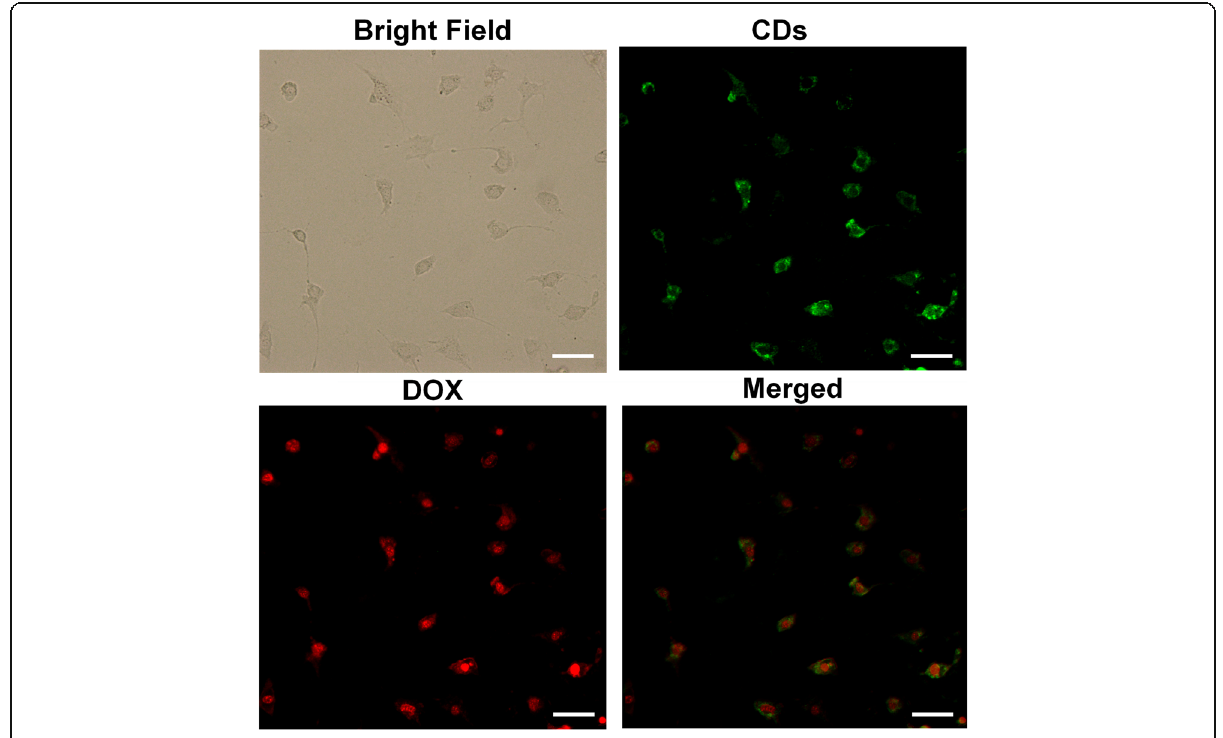
Fig. 4 In vitro cellular uptake of DOX-CDs by HO-8910 cells. Scale bar = 50 μ m